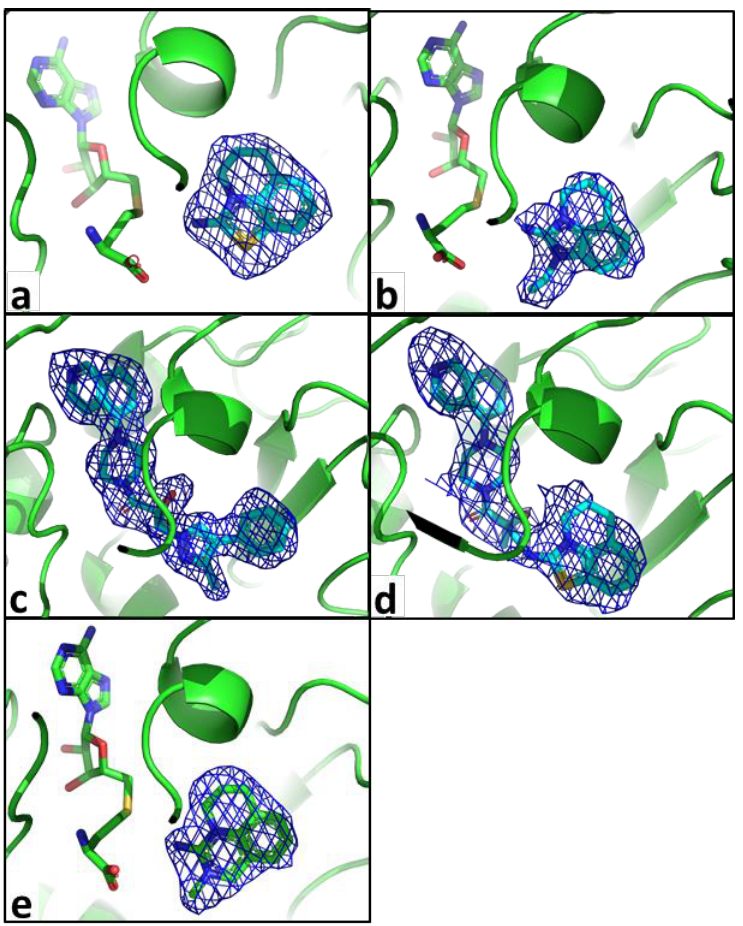
Figure 3. Omit maps, contoured at 2σ of h NNMT in complex with various inhibitors. ( a ) ( 2 ); 2.33 ( b ) ( 3 ); 2.81 Å, ( c ) ( 1 ); 2.28 Å, ( d ) ( 33 ); 2.8 Å, ( e ) ( 4 ); 2.9 Å. Omit maps are calculated by Å , ( b ) ( 3 ); 2.81 Å , ( c ) ( 1 ); 2.28 Å , ( d ) ( 33 ); 2.8 Å , ( e ) ( 4 ); 2.9 Å . Omit maps are calculated by subtract-